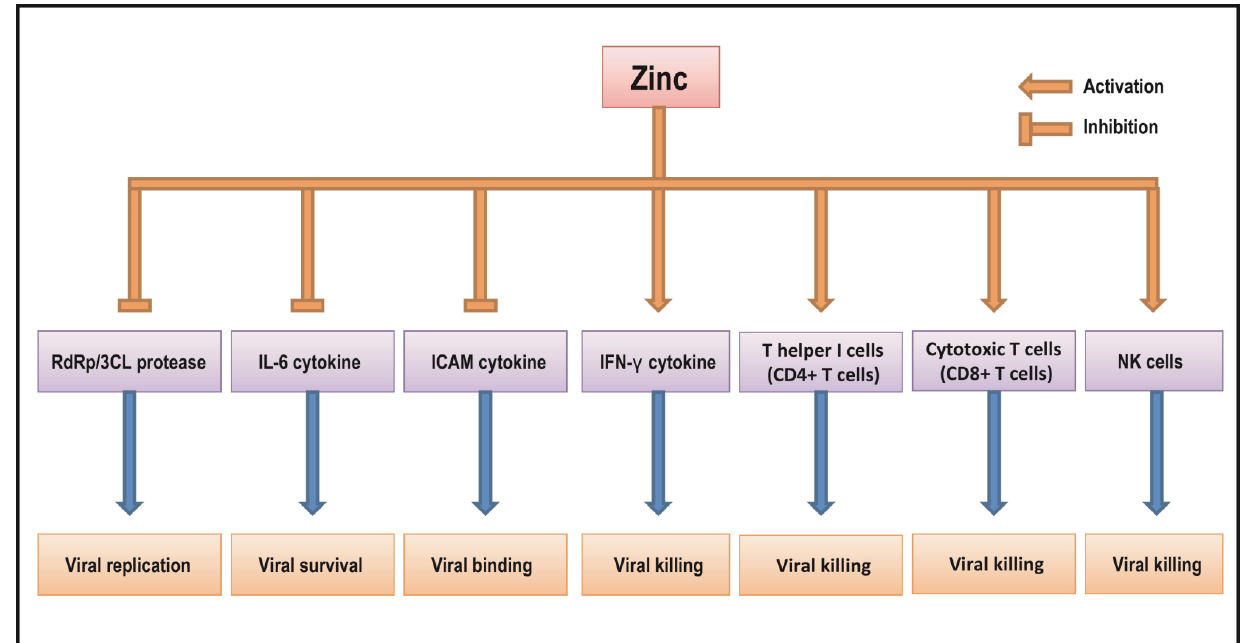
Figure 1. The putative mechanism of zinc action as an anti-viral agent in COVID-19.